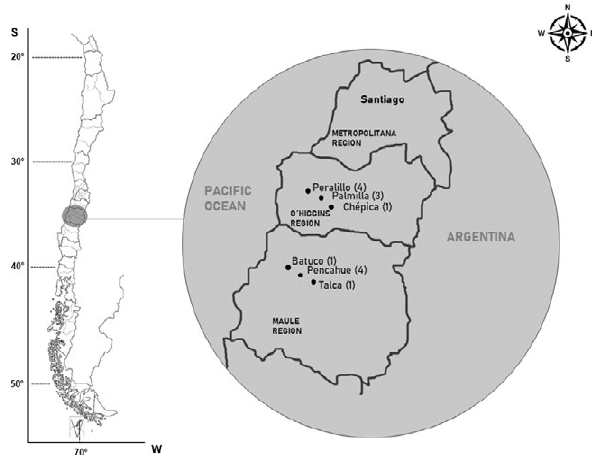
Figure 1. Sampling localities (black dots) in the Maule and O’Higgins Regions, Central Chile. The number of blocks analyzed in each locality is indicated in